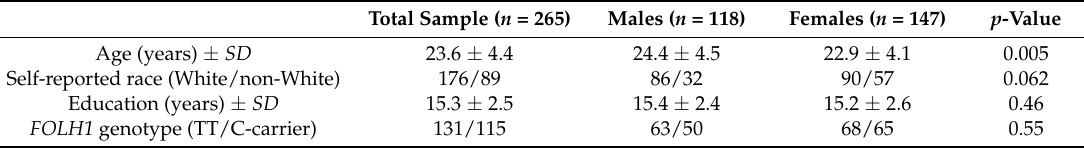
Table 1. Demographic characteristics of study